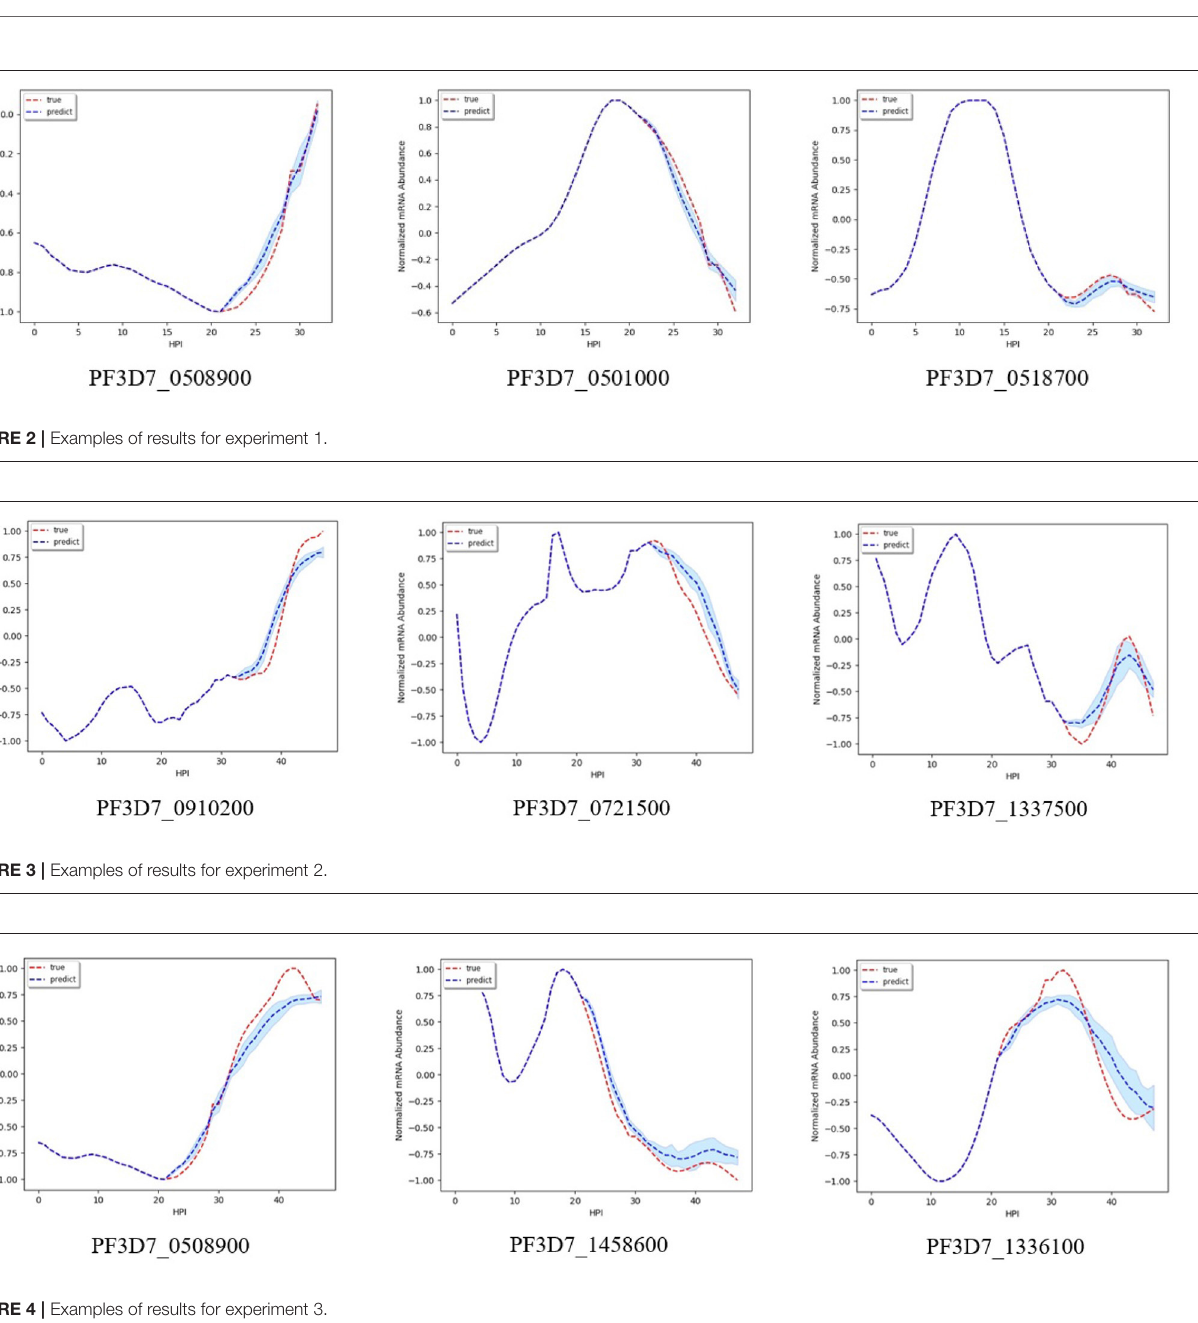
FIGURE 4 | Examples of results for experiment